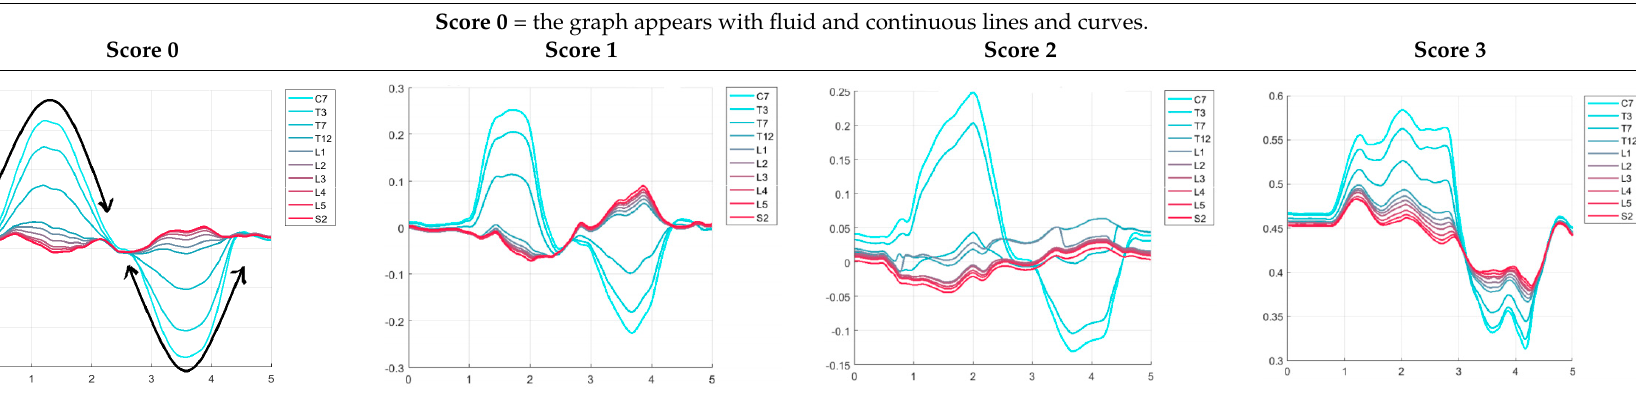
Table A2. Lateral Bending features.